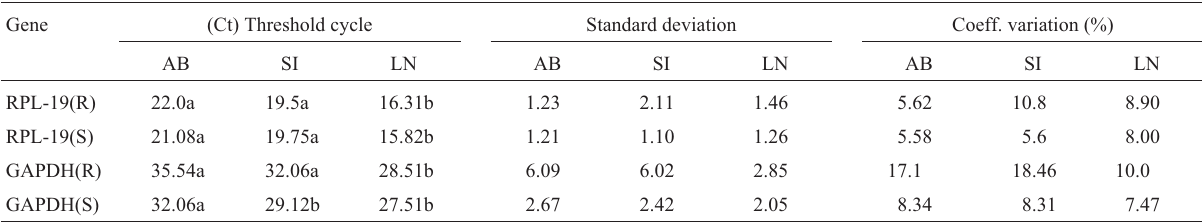
Table 2 - Analysis of RPL-19 and GAPDH in abomasum (AB), small intestine (SI) and abomasum lymph nodules (LN) from resistant (R) and suscepti- ble (S) animals. Gene (Ct) Threshold cycle Standard deviation Coeff. variation (%) AB SI LN AB AB